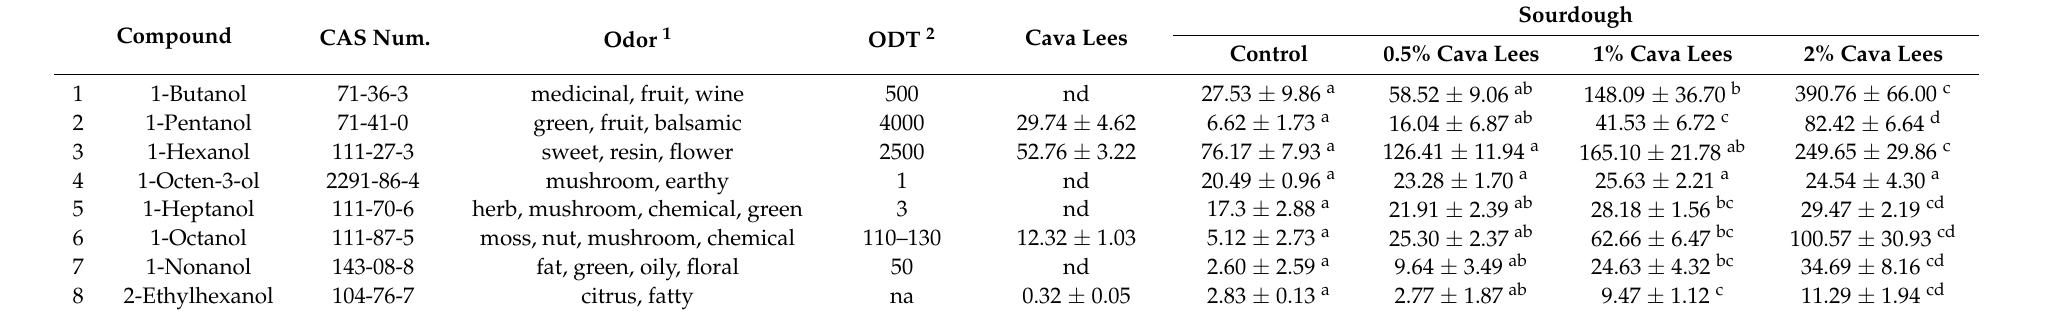
Table 2. Concentration (mg/kg) of the main alcohols obtained with the optimized extraction parameters in Cava lees and